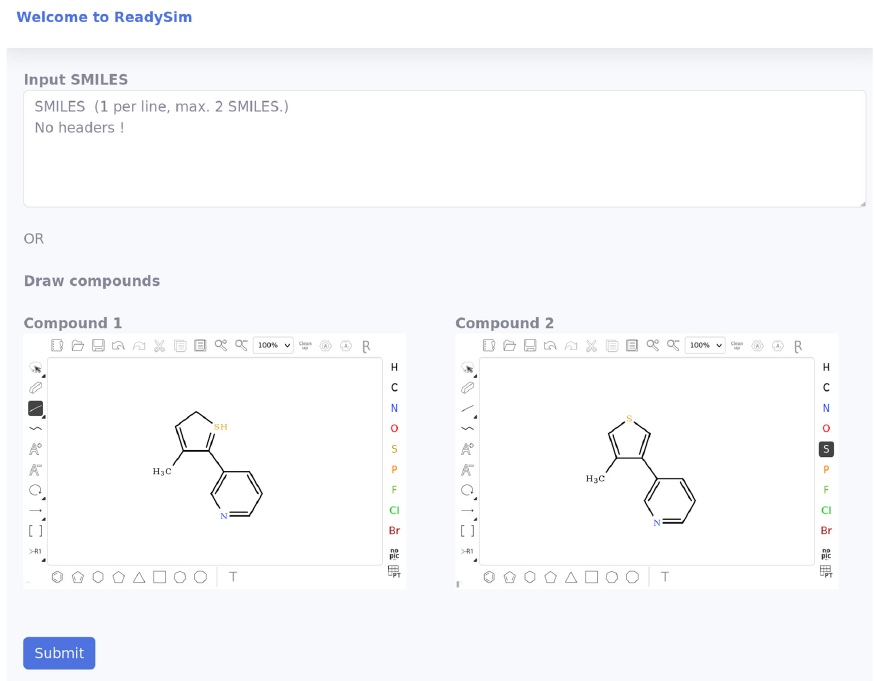
Figure 4. The web service ReadySim. The user can type in a molecular pair either as two SMILES strings or using the chemical sketchers below. The server standardizes the structures, computes the similarity and transforms it back as a probability that the pair will be considered as similar by a panel of